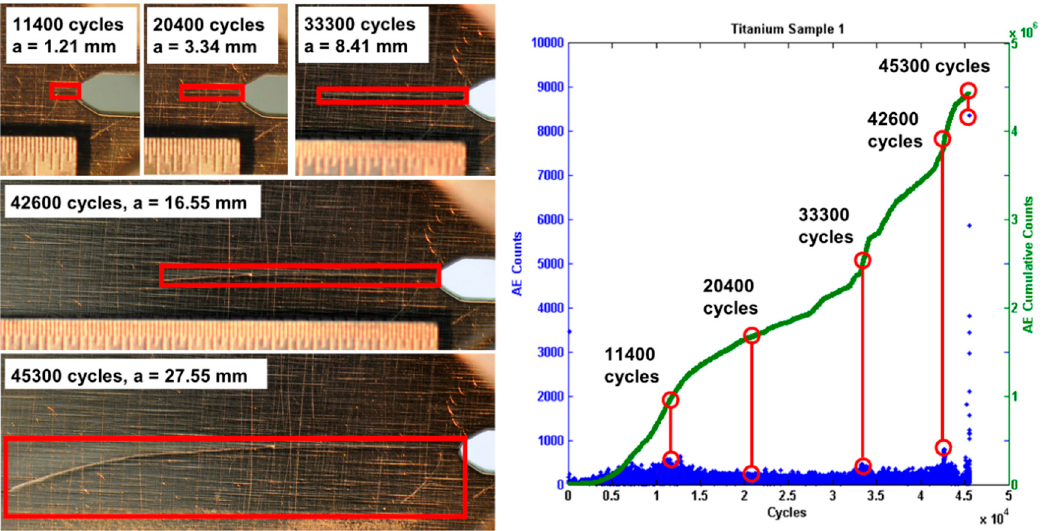
Figure 4. Example of crack length measurements paired with cumulative AE counts.